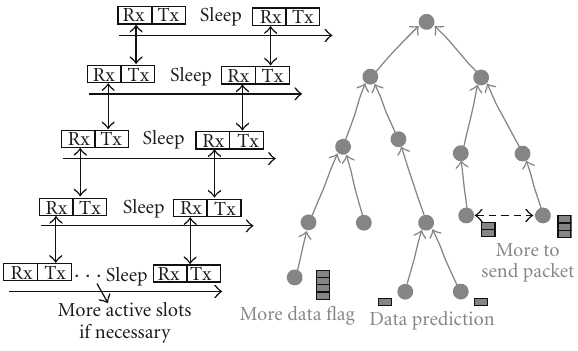
Figure 2: An illustration of DMAC